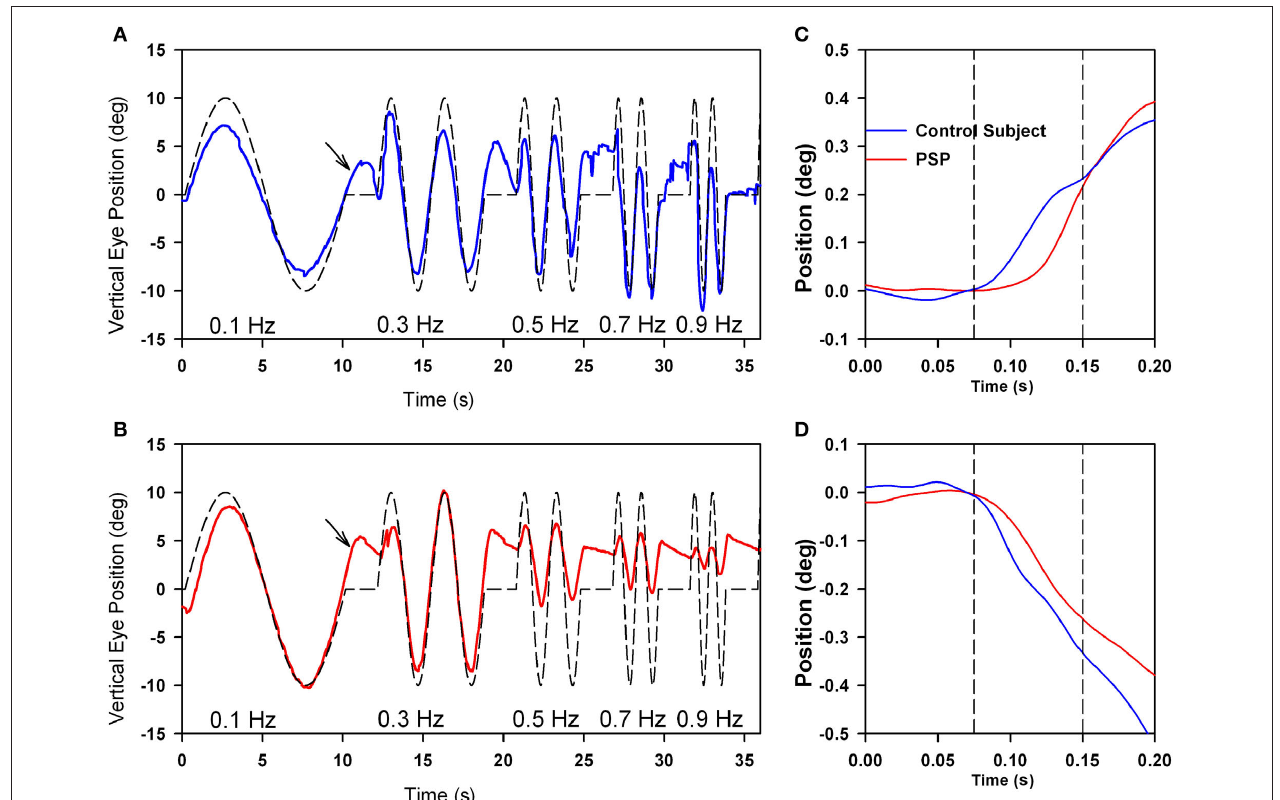
Figure 7 | Comparison of vertical smooth pursuit (A,B) and ocular following responses (C,D) of a normal subject and a PSP patient. Both sets of responses were evoked as subjects viewed vertically-moving sine-wave gratings on a monitor subtending 50 ° × 37.5 ° . For pursuit, the stimulus was sinusoidal motion of a 0.27 cycles per degree grating over the range of temporal frequencies shown. For OFR, the stimulus was ramp motion for 200 ms of a 0.17 cycles per degree grating. At lower frequencies of motion,